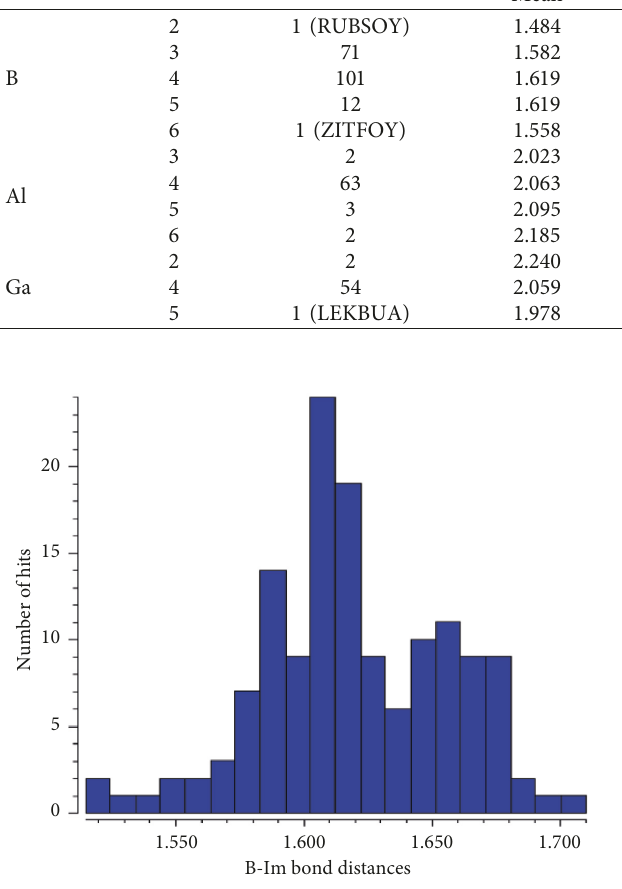
Table 3: M-Im distances, bond angles, and coordination numbers (CN) of the group IIIA metal-imidazol-2-ylidenes. Metal